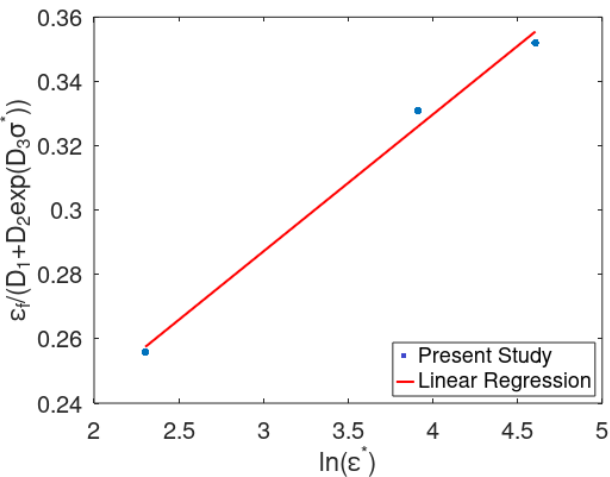
Figure 6. Determination of D 4 at various strain rates for notched specimen.